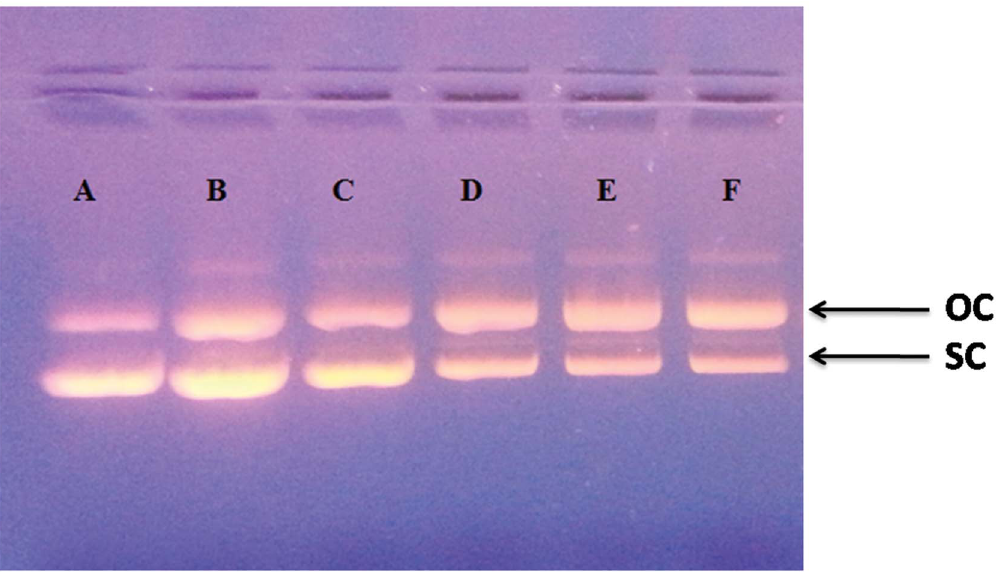
Figure 11. 6MP induced damage to plasmid DNA in presence of light. Agarose gel electrophoresis pattern of ethidium bromide stained pBR322 DNA after the treatment with 6MP in presence of white light. Lane ‘ A ’ depicts the ‘Control’ which contain only plasmid DNA. The concentrations of 6MP in lanes ‘ B–F ’ was 100, 200, 300, 400 and 500 m M respectively. Arrows indicating OC and SC on the right represent the open circular and supercoiled forms of plasmid DNA.